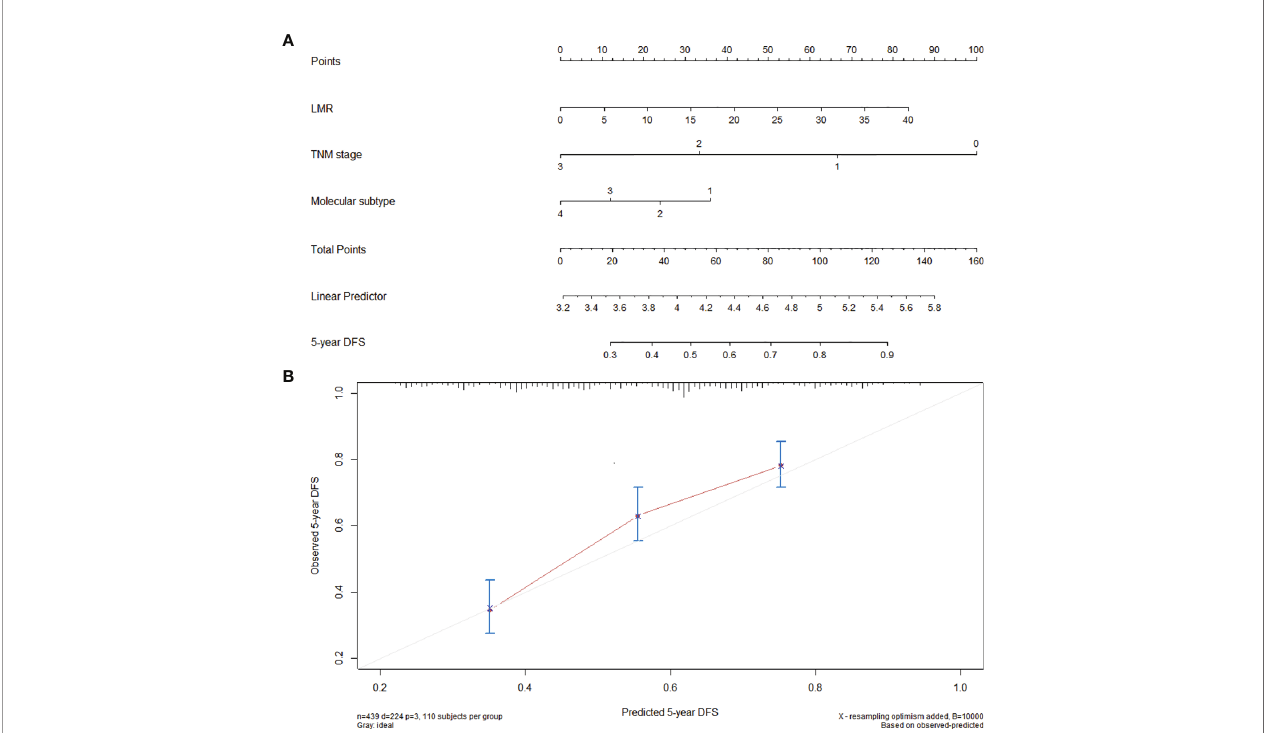
FIGURE 2 | Nomogram for the prediction of DFS. (A) A nomogram for predicting the 5-year DFS for 440 patients with breast cancer (molecular subtype: 1 = luminal A, 2 = luminal B, 3 = HER-2, 4 = TNBC). To calculate the 5-year DFS for a speci fi c patient, locate patient ’ s pretreatment LMR and draw a line straight upward to the Points axis to determine the score associated to that LMR. Repeat the process for TNM stage and molecular subtype, sum the scores, and locate this sum on the Total Points axis. Then, draw a line straight down to the corresponding “ 5-year DFS ” axis to fi nd the predicted 5-year DFS. (B) Calibration curves for 5-year DFS using nomograms with TNM stage, molecular subtype, and pretreatment LMR are shown. The x -axis is nomogram predicted probability of survival and y -axis is actual survival. The bootstrapping method was used for the internal validation of the nomogram. The gray line indicates perfect